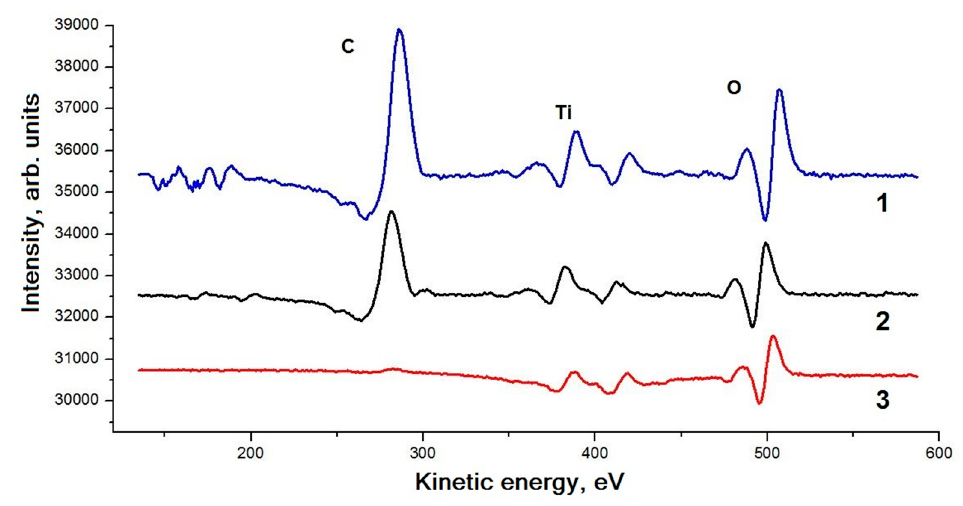
Figure 1. Auger spectroscopy results: 1, a titanium dioxide film synthesized according to a method in [31]; 2, a titanium wire; and 3, a freshly prepared titanium coating sample.